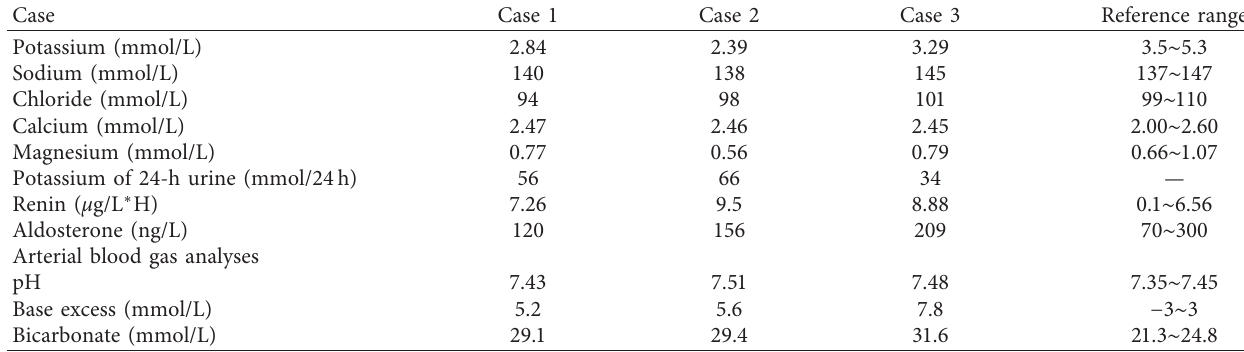
Table 1: Serum electrolytes, 24-hour urine potassium, blood gas analysis, and renin aldosterone levels of the 3 cases.